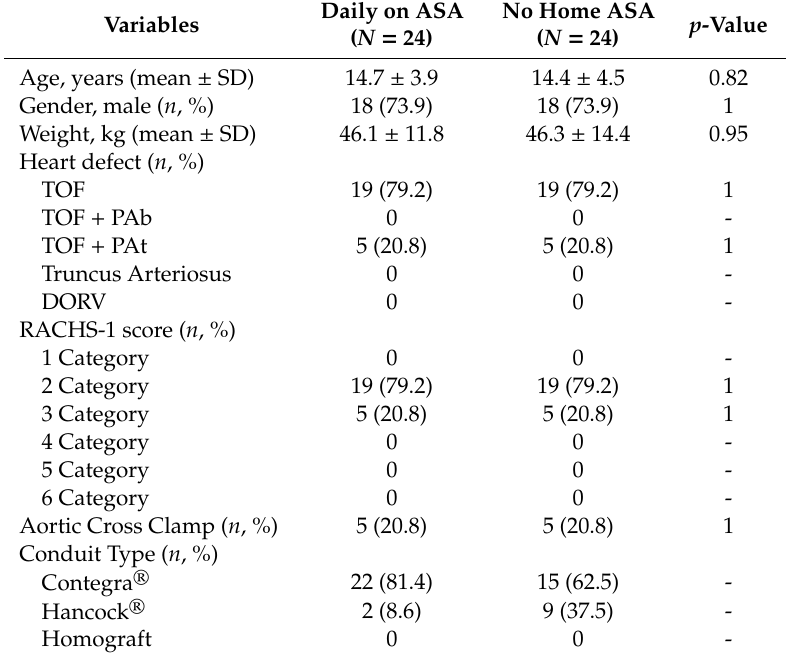
Table 2. Baseline sociodemographic and clinical characteristics of 24 propensity-matched patients. Daily on ASA Variables ( N =